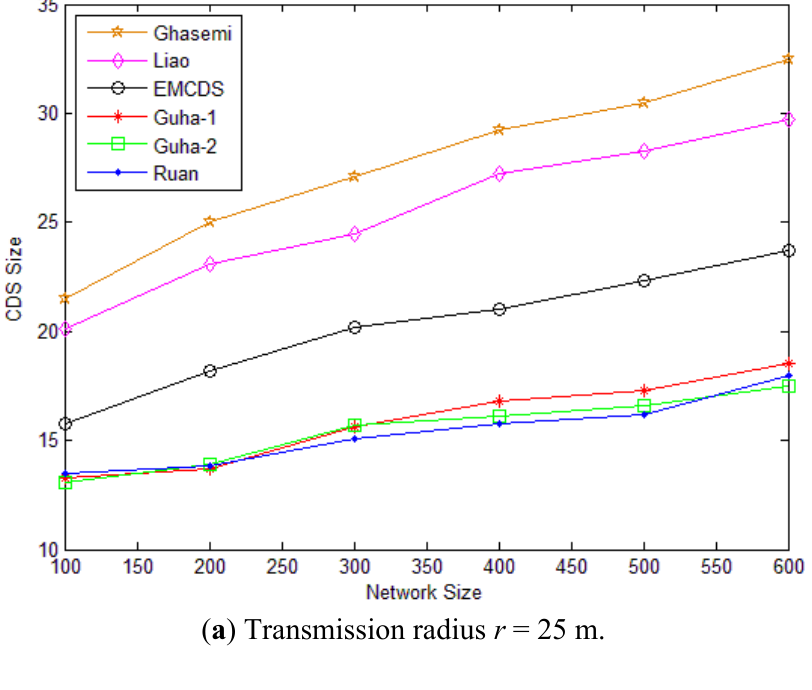
Figure 8. The size of MCDS with different number of nodes. ( a ) Transmission radius r = 25 m; ( b ) Transmission radius r = 50